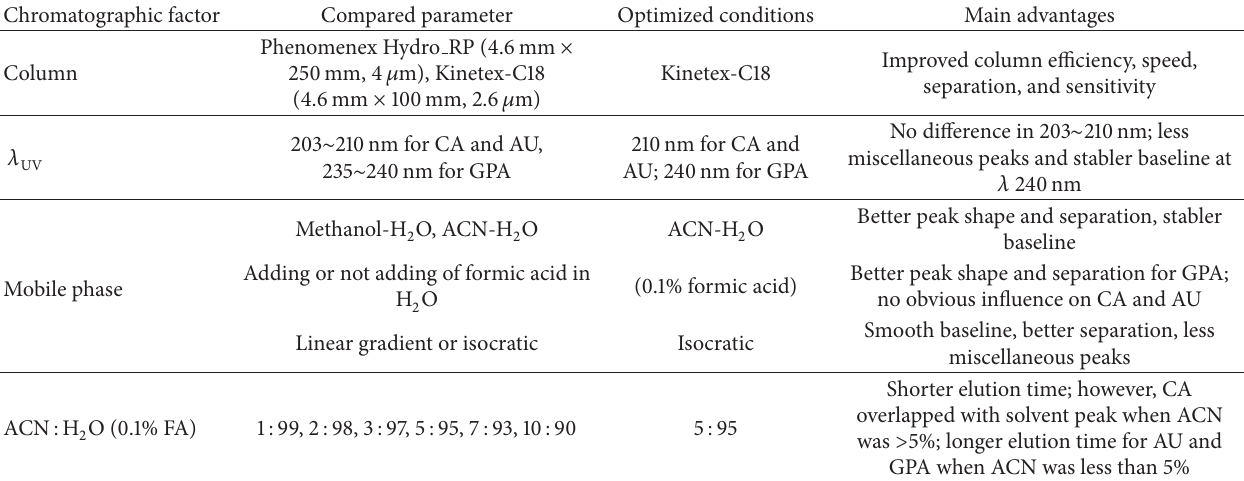
Table 1: Optimization of HPLC-UV conditions for three analytes.